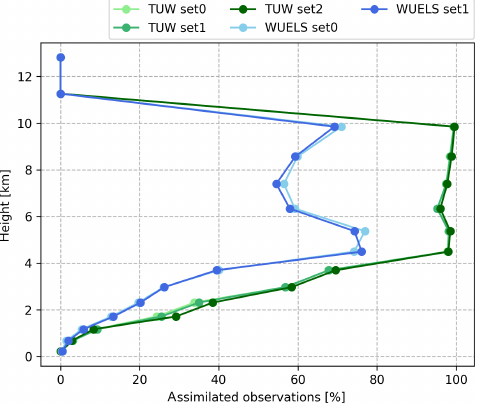
Figure 11. Percentage of observations successfully assimilated for TUW (green) and WUELS (blue) models as a function of height.